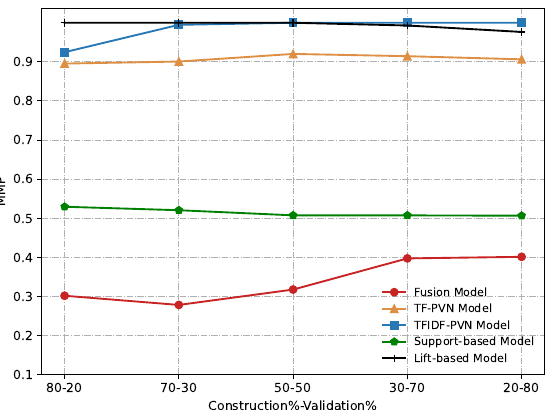
Figure 13. Comparative results of the Fusion model, TF-PVN model, TFIDF-PVN model, Support- based model and Lift-based model in terms of MMP.